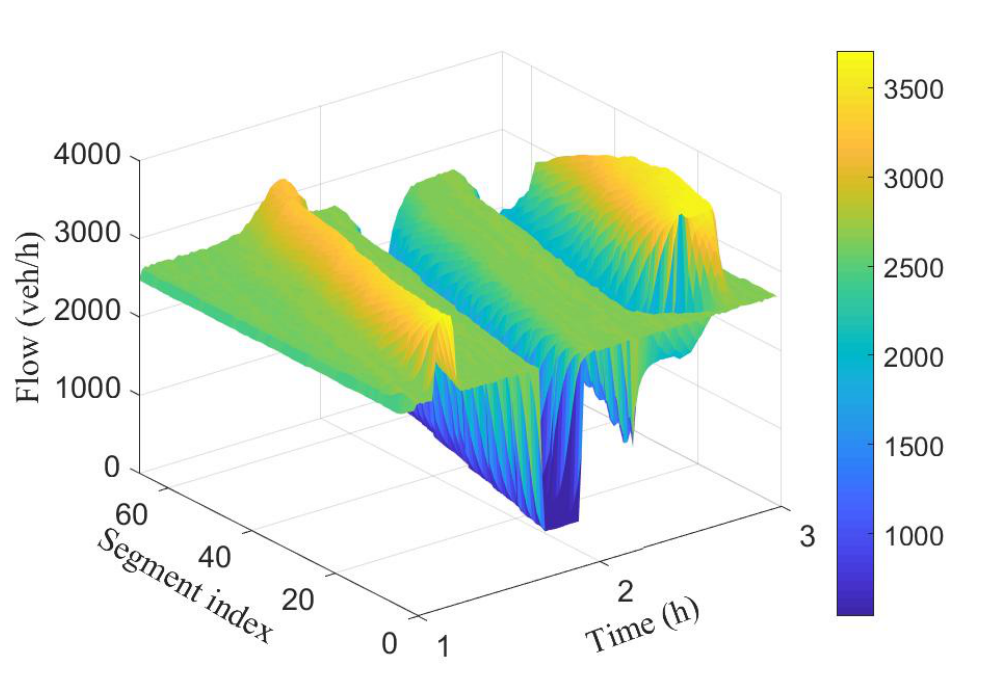
Figure 3. Spatio-temporal evolution of traffic flow for the 100